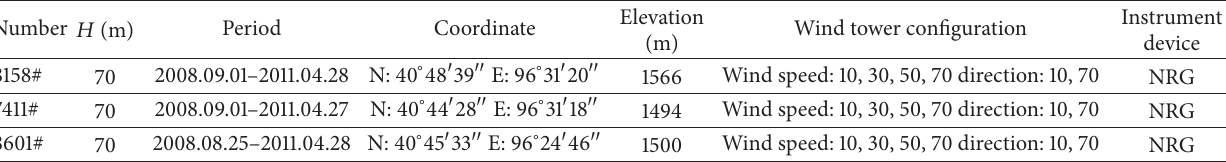
Table 1: Site specific information of meteorological stations considered in this paper.